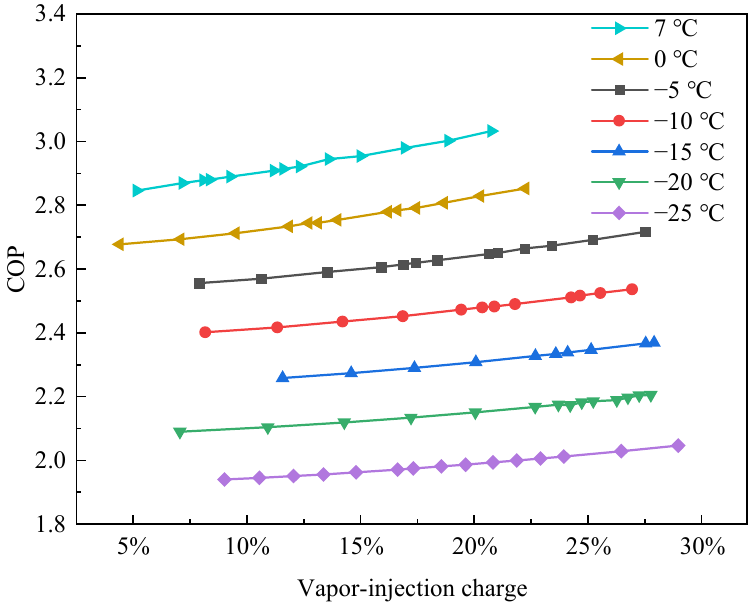
Figure 8. The effect of vapor-injection charge on the COP of the HHE–ASHPD system.